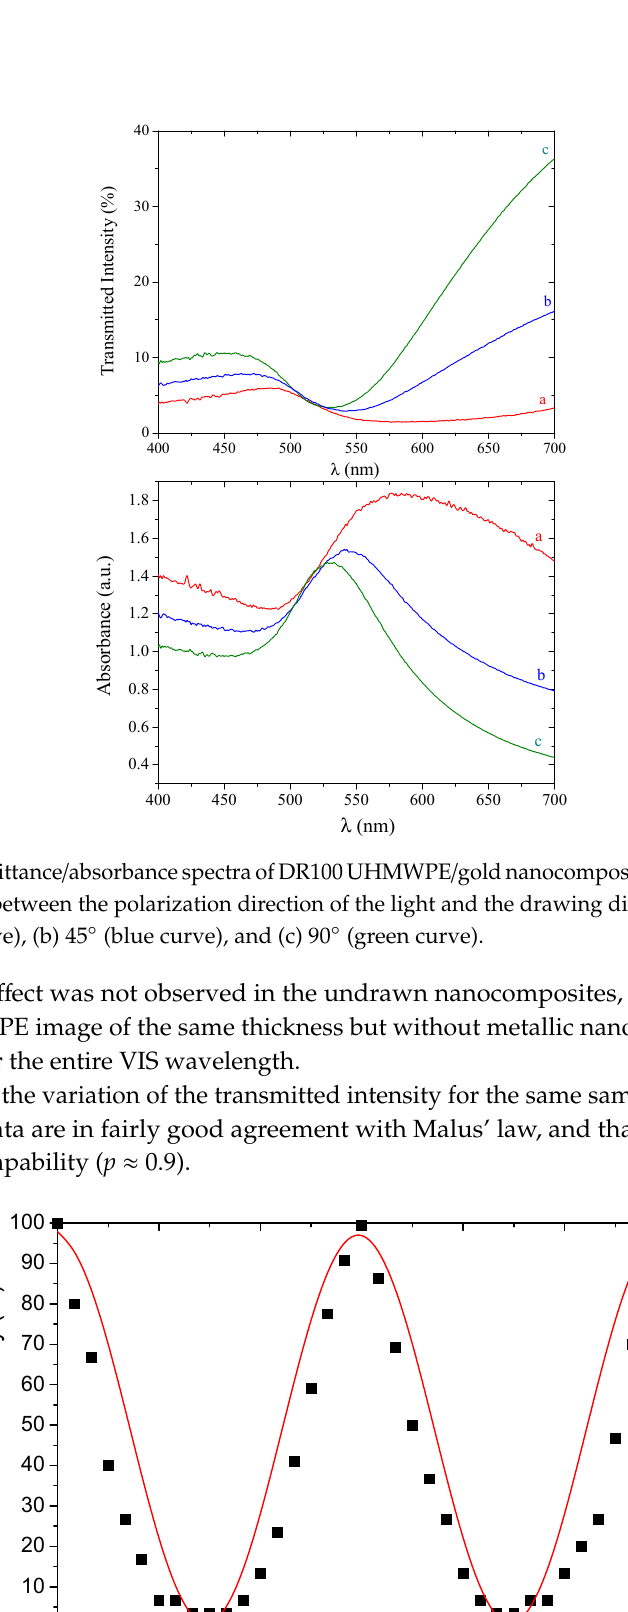
Figure 3. Transmitted intensity (black squares) in linearly polarized light for DR100 nanocomposite as a function of the angle θ between the polarization direction of the light and the drawing direction of the film. The red curve is a fit of experimental points according to Malus’ law.